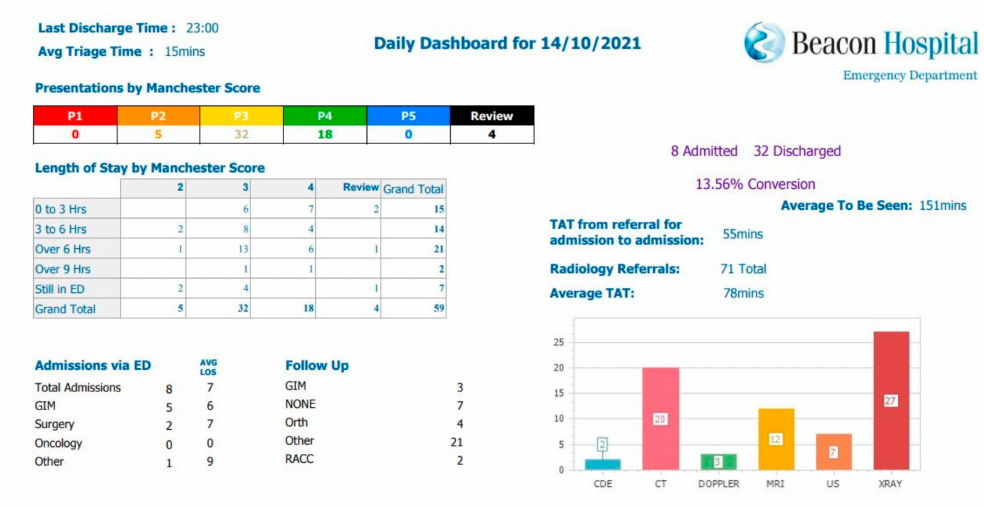
Figure 4. Sample of the ED daily report.